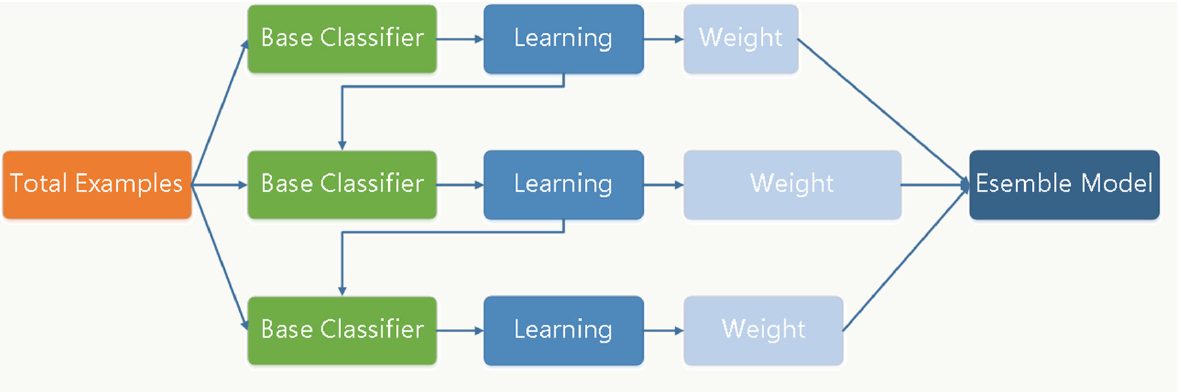
Figure 3. GBDT classification method in this experiment. The method included 3 steps: data set division, classification model training, and obtaining the result from the best model.